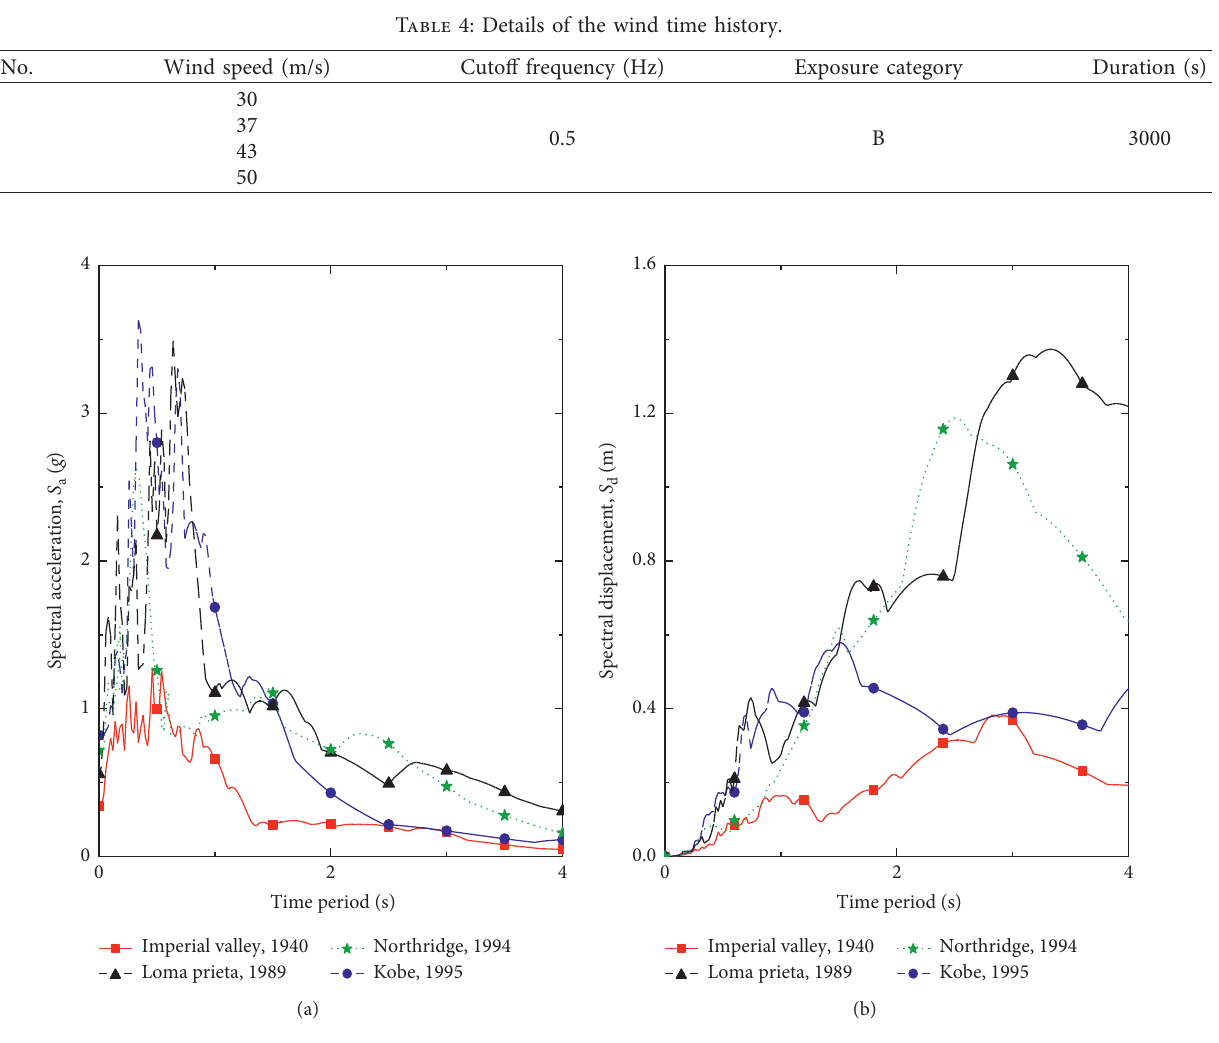
Figure 4: Acceleration and displacement response spectra of the considered historical earthquake ground motions.